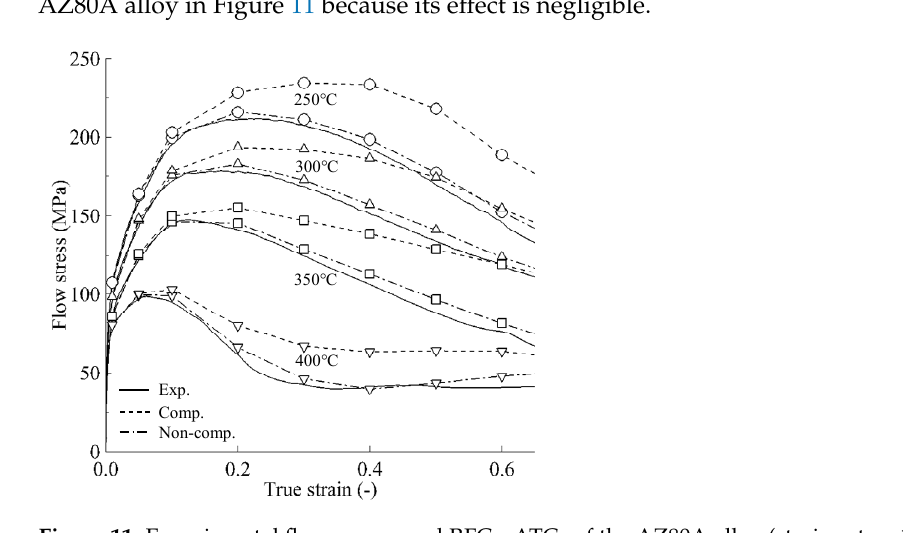
Figure 11. Experimental flow curves and RFCs–ATCs of the AZ80A alloy (strain rate = 10 s − 1 )